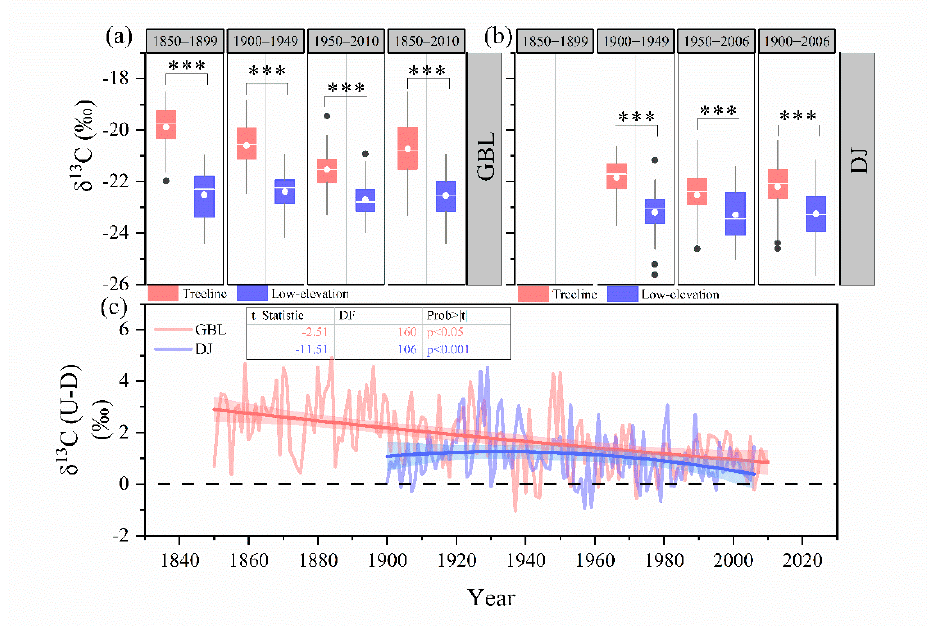
Figure 3. Comparisons of the mean values of tree-ring δ 13 C between the treeline (U) and low-elevation (D) plots for the two elevational transects GBL and DJ over different time periods ( a , b ), and ( c ) the difference (U-D) in BAI between treeline and low elevation. The black dots represent outliers as judged by more than 3 standard deviations departed from the mean values. *** denotes significant difference of means between the compared groups at p < 0.001 level. The bold lines in ( c ) are regression lines and the shaded area denotes the 95% confidence intervals of the regressions.